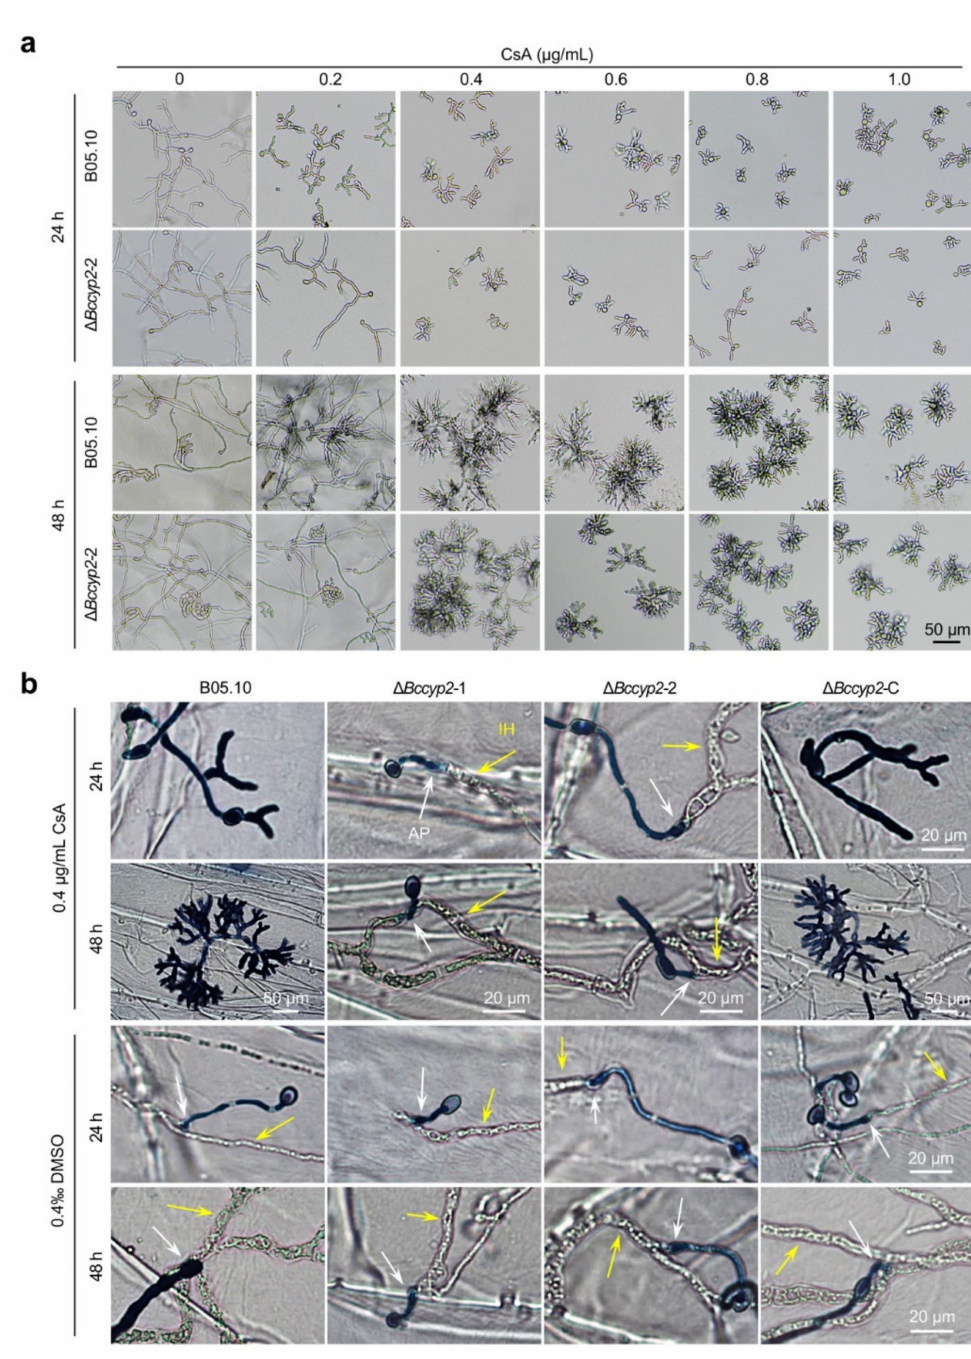
Figure 6. Effects of CsA on infection-related morphogenesis as well as host penetration and growth of invasive hyphae. ( a ) Suppression of B. cinerea mycelial growth by CsA. Conidia (5 × 10 4 conidia/mL in 1 liquid CM, 200 µ L) of the indicated strains mixed with CsA (0, 0.2, 0.4, 0.6, 0.8, or 1.0 µ g/mL) 2 were inoculated in 96-well plates and cultured at 20 ◦ C. Mycelial morphogenesis of the tested strains was observed and photographically documented at 24 and 48 hpi. ( b ) Suppression of B. cinerea infection by CsA. Conidia of each strain (5 × 10 4 conidia/mL, 20 µ L) mixed with or without CsA were inoculated on onion epidermis and cultured at 20 ◦ C. The solvent (DMSO) treated inoculation was used as a control. At 24 or 48 hpi, the inoculated epidermal cells were performed lactophenol aniline blue staining, microscopy observation and imaging. AP: appressorium, IH: invasive hyphae. Representative images are from one of the experiments, at least three independent experiments were performed, and all the experiments resulted in similar